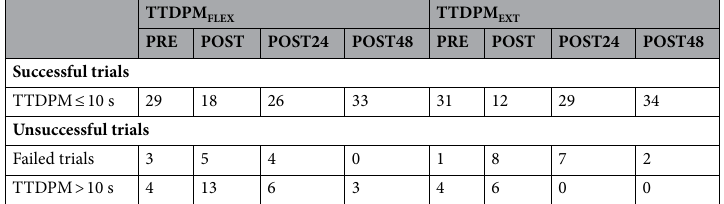
TTDPM FLEX TTDPM